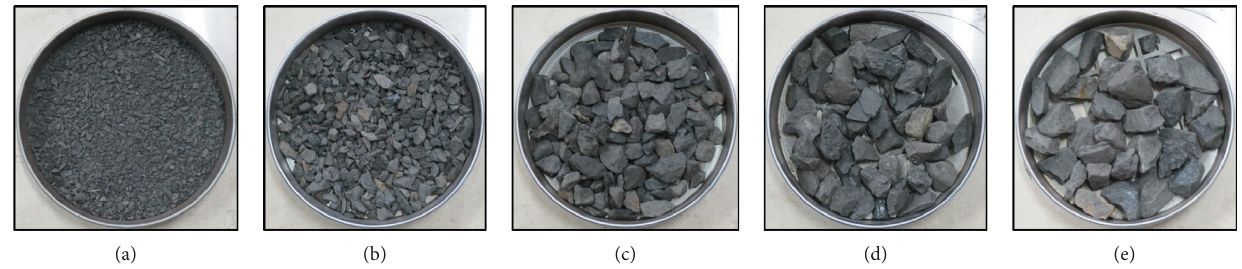
Figure 2: Gangue samples of different gradations. (a) 0–10mm, (b) 10–20 mm, (c) 20–30mm, (d) 30–40 mm, and (e) 40–50mm.